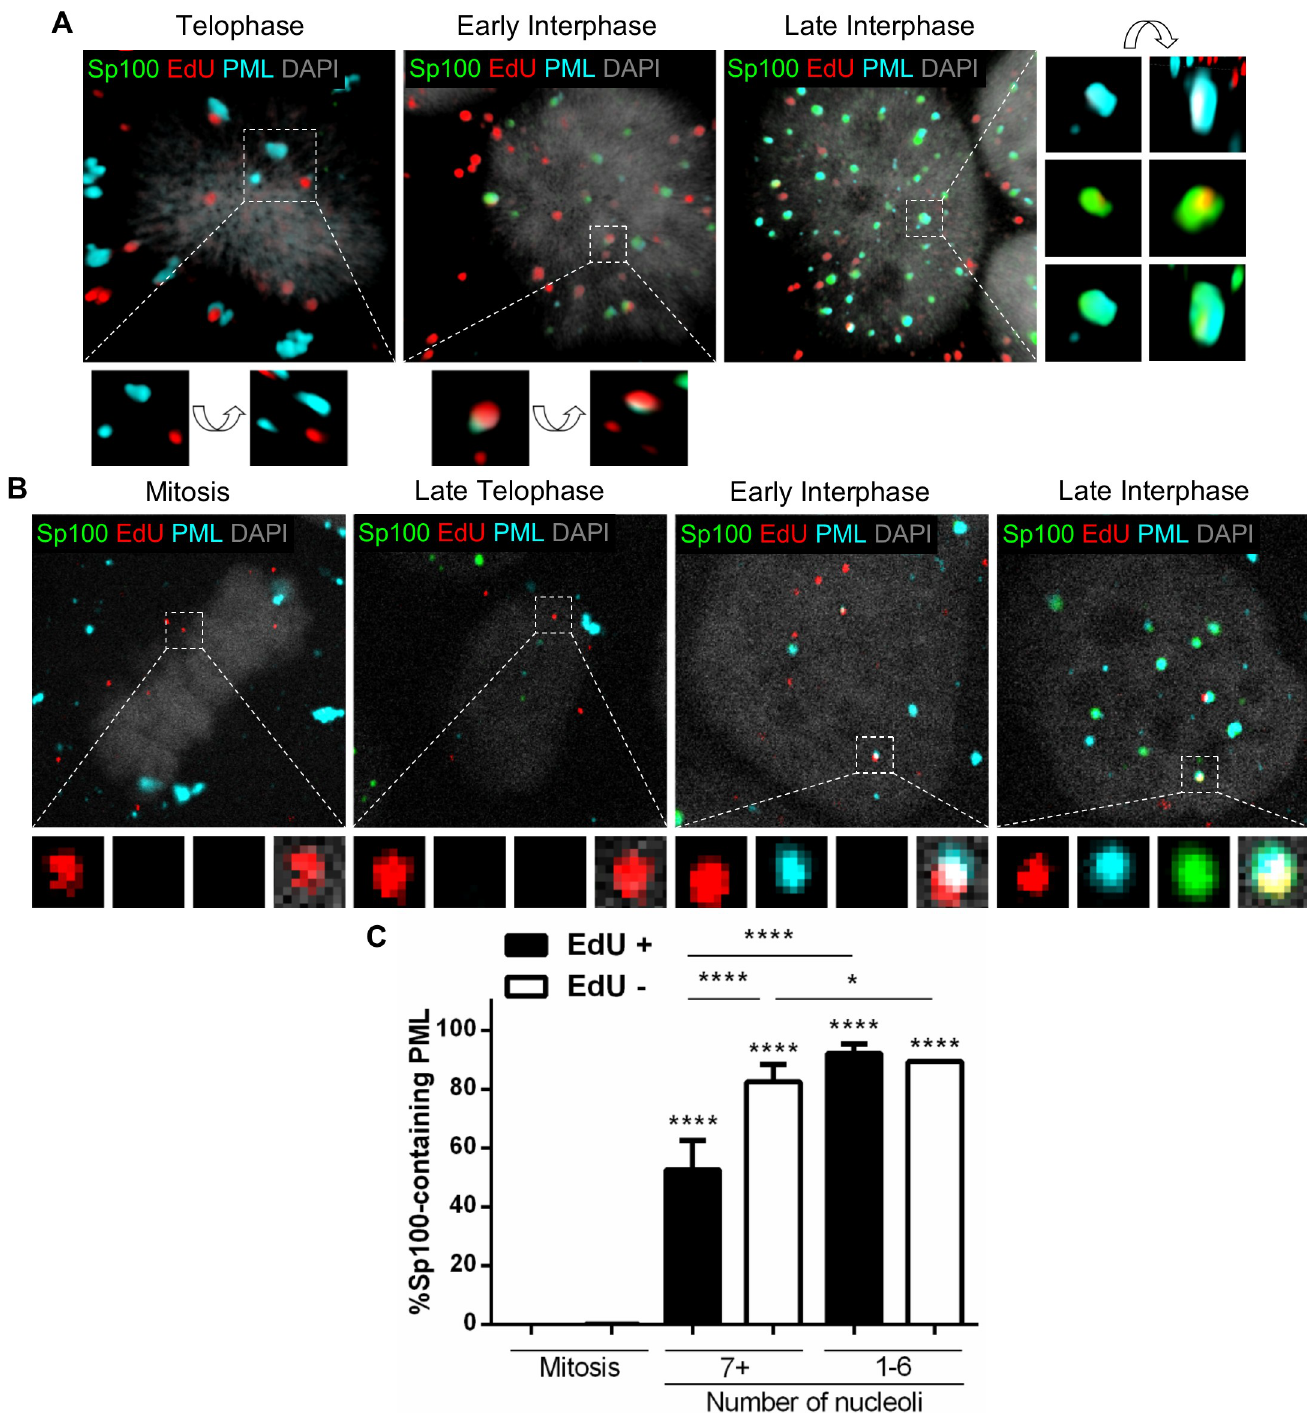
Fig 7. Sp100 recruitment to the viral genome is delayed compared to PML protein. (A and B) HaCaT cells were infected with EdU-labeled PsVs for 24 h, fixed, permeabilized, and treated with Click-iT reaction buffer with AF555 dye to stain EdU-labeled pseudogenomes (red). Next, the cells were incubated with mouse anti- PML protein antibody (cyan) and rabbit anti-Sp100 antibody (green) and mounted in DAPI (white). (A) Images show 3D reconstruction of high resolution z-stacks. Close-up images were rotated at a 45˚ angle on the x, y, z axes in the 3D-rendered images. (B) Representative confocal images of the following quantification. (C) Percent Sp100-containing PML was determined by manually counting the PML protein puncta co-localizing with Sp100 puncta also co-localizing with EdU puncta (EdU+) or not (EdU-) associated with condensed chromosomes in mitotic cells or nuclear-localized in interphase cells. Nucleoli were also counted: 7+ nucleoli